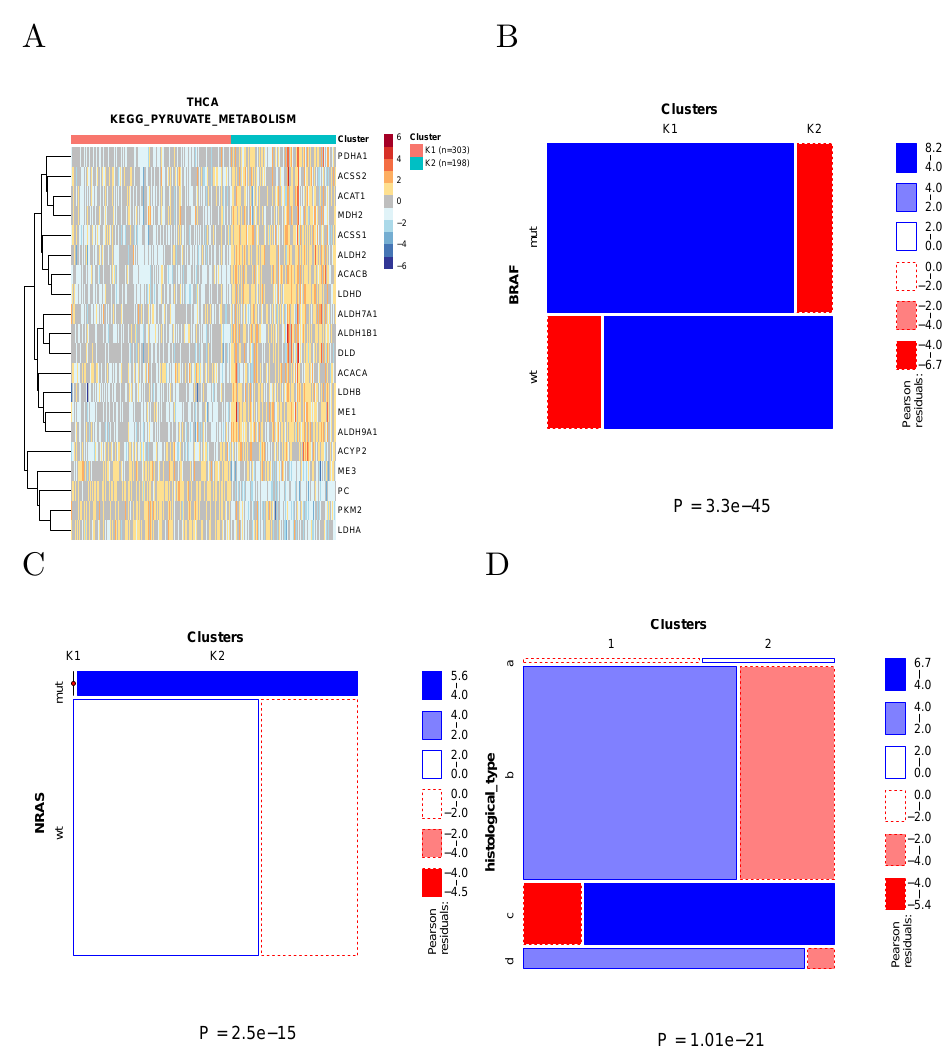
Figure 6. ( A ) Clustering of thyroid cancer samples using the genes associated with KEGG to pyruvate metabolism. ( B ) Most BRAF-mutated samples fell into Cluster 1. ( C ) All NRAS-mutated samples fell into Cluster 2. ( D ) The two clusters significantly differed in the prevalence of histological types; (a): other type; (b): thyroid papillary carcinoma—classical/usual; (c): thyroid papillary carcinoma— follicular (>= 99% follicular patterned); (d): thyroid papillary carcinoma—tall cell (>= 50% tall cell